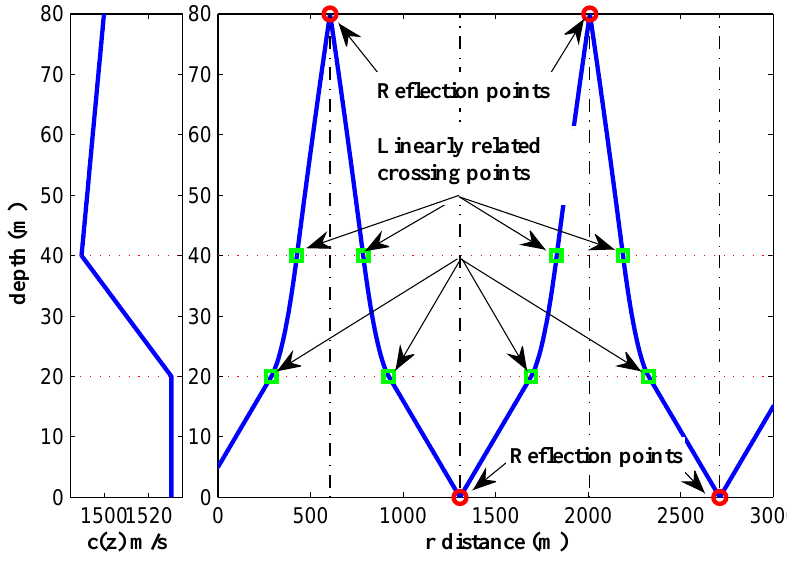
Figure 4. Linear dependency of the reflection and crossing points under the assumption of a perfect